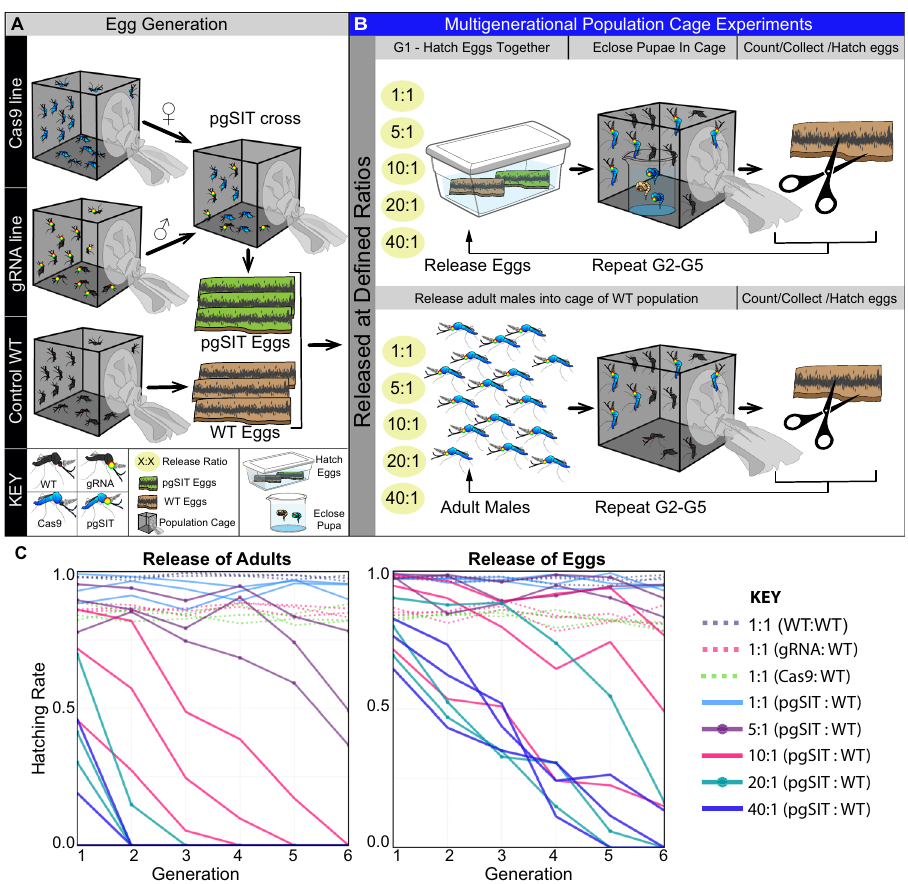
Fig. 3 Multigenerational cage trials demonstrating ef fi cient population suppression. A To generate suf fi cient mosquito numbers, three lines were raised separately, including homozygous Cas9 , double-homozygous gRNA β Tub + myo-fem , and WT. To generate pgSIT progeny, virgin Cas9 ♀ ’ s were genetically crossed to gRNA β Tub + myo-fem ♂ ’ s, and eggs were collected. B To perform multigenerational population cage trials of pgSIT, two strategies were employed: release of eggs ( B , top panel); release of mature adults ( B , bottom panel). For both strategies, multiple pgSIT:WT release ratios were tested, including: 1:1, 5:1, 10:1, 20:1, and 40:1. Each generation, total eggs were counted, and 100 eggs were selected randomly to seed the subsequent generation. The remaining eggs were hatched to measure hatching rates and score transgene markers. This procedure was repeated after each generation until each population was eliminated (Supplementary Table 16). C Multigenerational population cage data for each release threshold plotting the proportion of eggs hatched each generation. Source data are provided as a Source Data fi